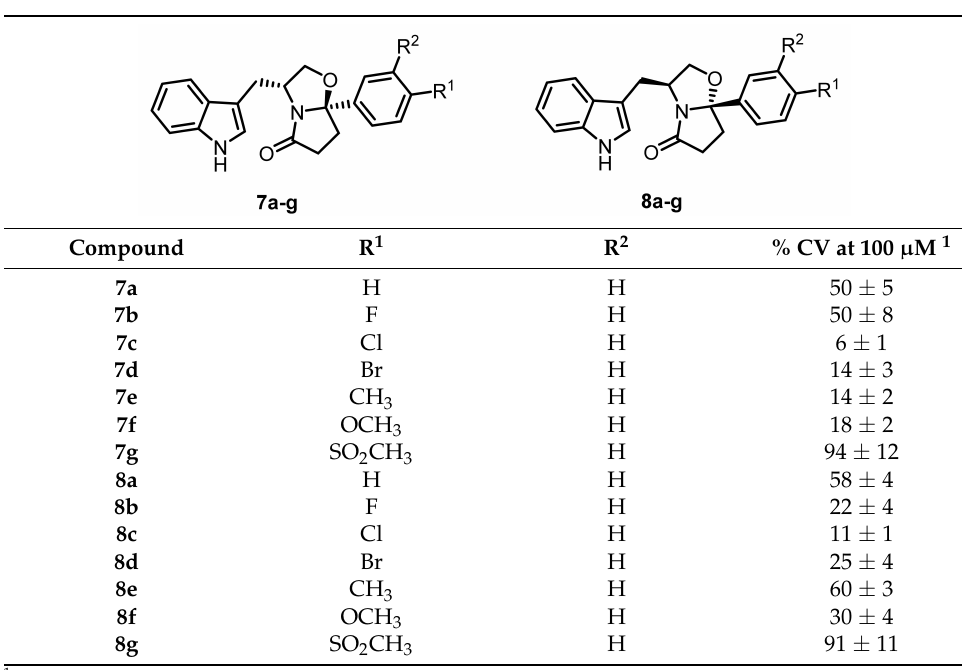
Table 1. Screening of ( R ) and ( S )-tryptophanol-derived oxazolopyrrolidone lactams 7a – g and 8a – g in AGS cell